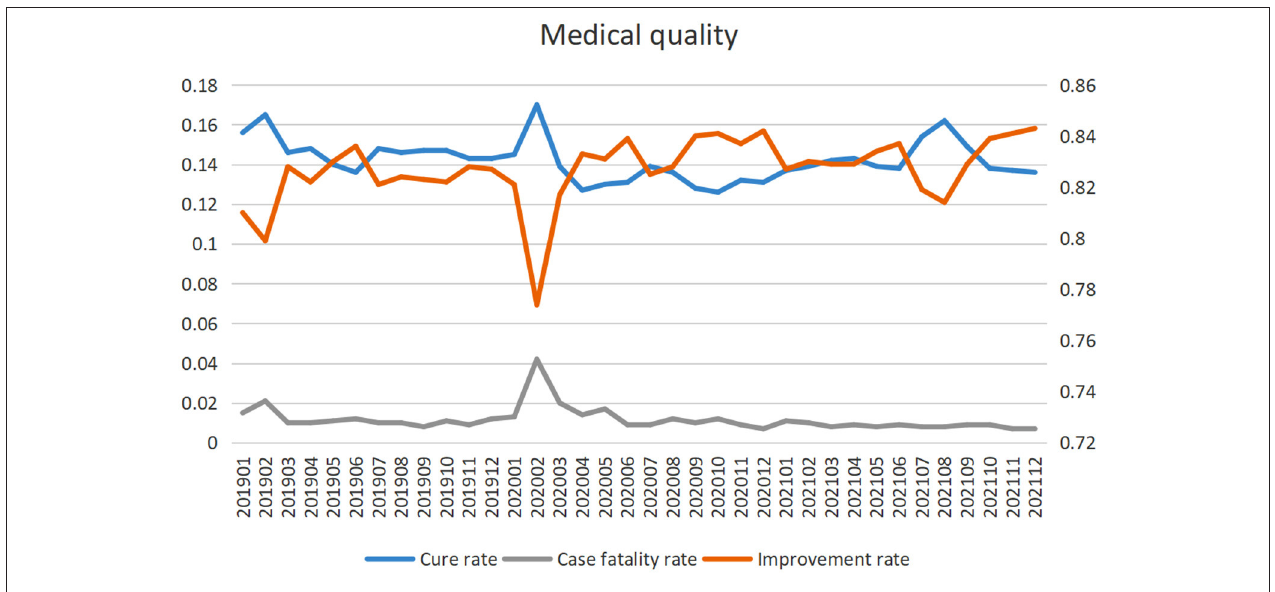
FIGURE 2 | Medical quality